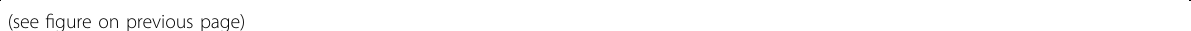
Fig. 1 Overall structure of the infectious GETV virion determined by cryo-EM at 2.8 Å resolution. a – c Ninety 3-day-old mice were randomly divided into two groups and inoculated oronasally with strain GETV-V1 suspension or an equal amount of DMEM. a Motor disabilities displayed in GETV-inoculated mice at 4 DPI; by 8 DPI, all of the GETV-inoculated mice displayed paralysis. b Mice inoculated with GETV died at 6 DPI, and all of the inoculated mice were dead by 12 DPI. c Tissue from hippocampal dentate gyrus in the brain and spinal cord under lumbar vertebrae were subjected for immuno-histochemistry analysis. There were abundant GETV antigens distributed in the brain and spinal cord under lumbar vertebrae in the inoculated newborn mice (highlighted in red circles). d – h Cryo-EM structure of GETV at 2.8 A ̊ resolution. d GETV virion showing the external surface with assigned symmetry axes. e Central cross-section of the GETV density map. f , g Density map and atomic model of one asymmetric unit. The E1, E2, and capsid proteins are colored separately in magenta, orange and green. h Atomic model of E1 – E2 – capsid heterotrimer. Different subdomains